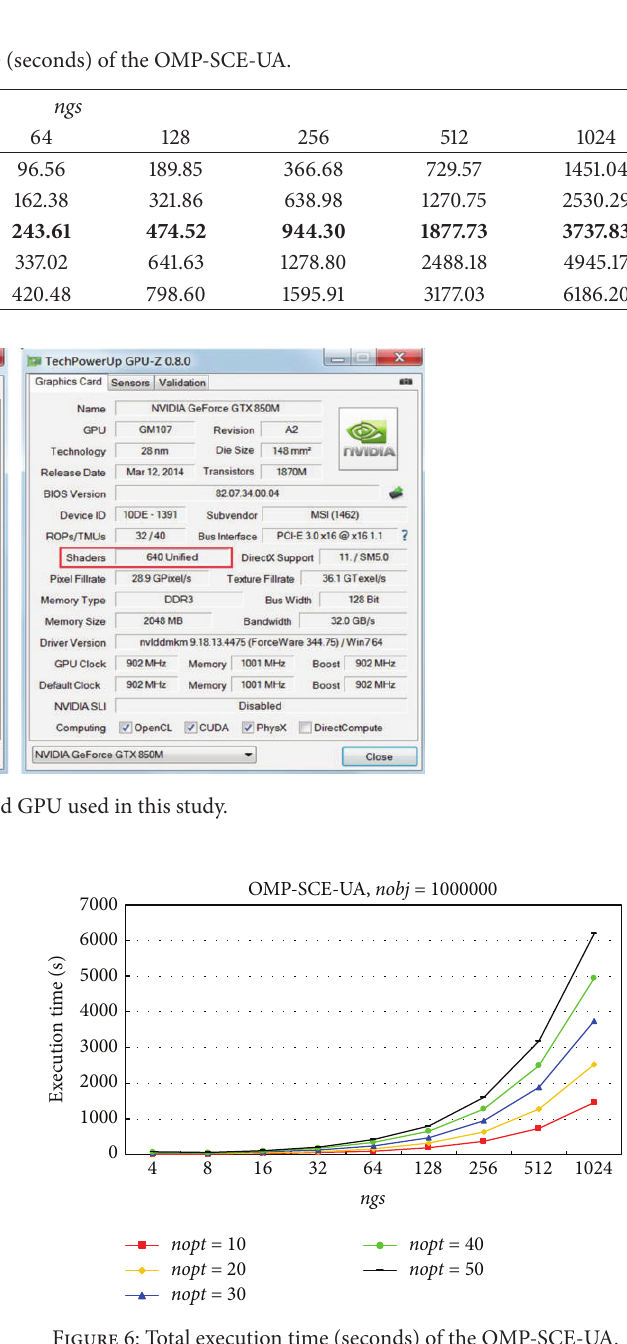
Figure 5: Total execution time (seconds) of the Serial-SCE-UA. Figure 6: Total execution time (seconds) of the